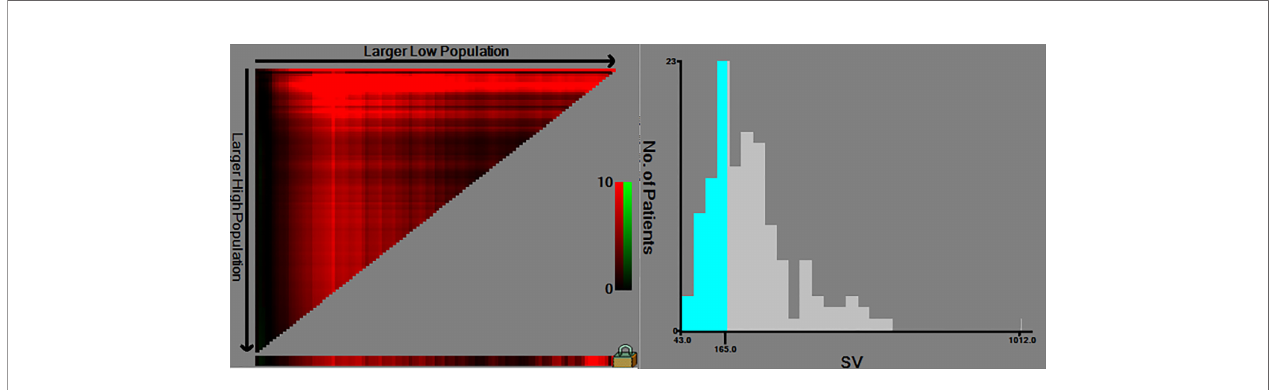
FIGURE 4 | The cut-off values were calculated by using X-tile based on the SV. The cut-off values were 167 for RFS. SV, splenic volume; RFS, recurrence-free survival.